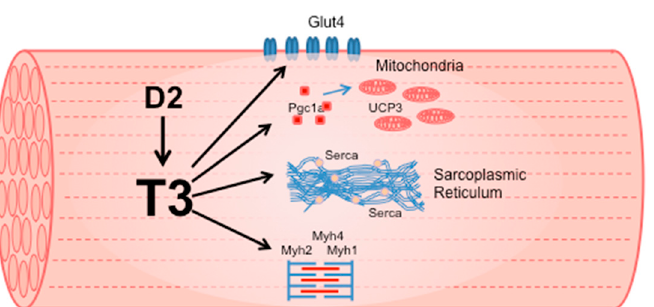
Figure 1. TH induces the expression of multiple genes that code for proteins essential to defining muscle contractile and metabolic properties.